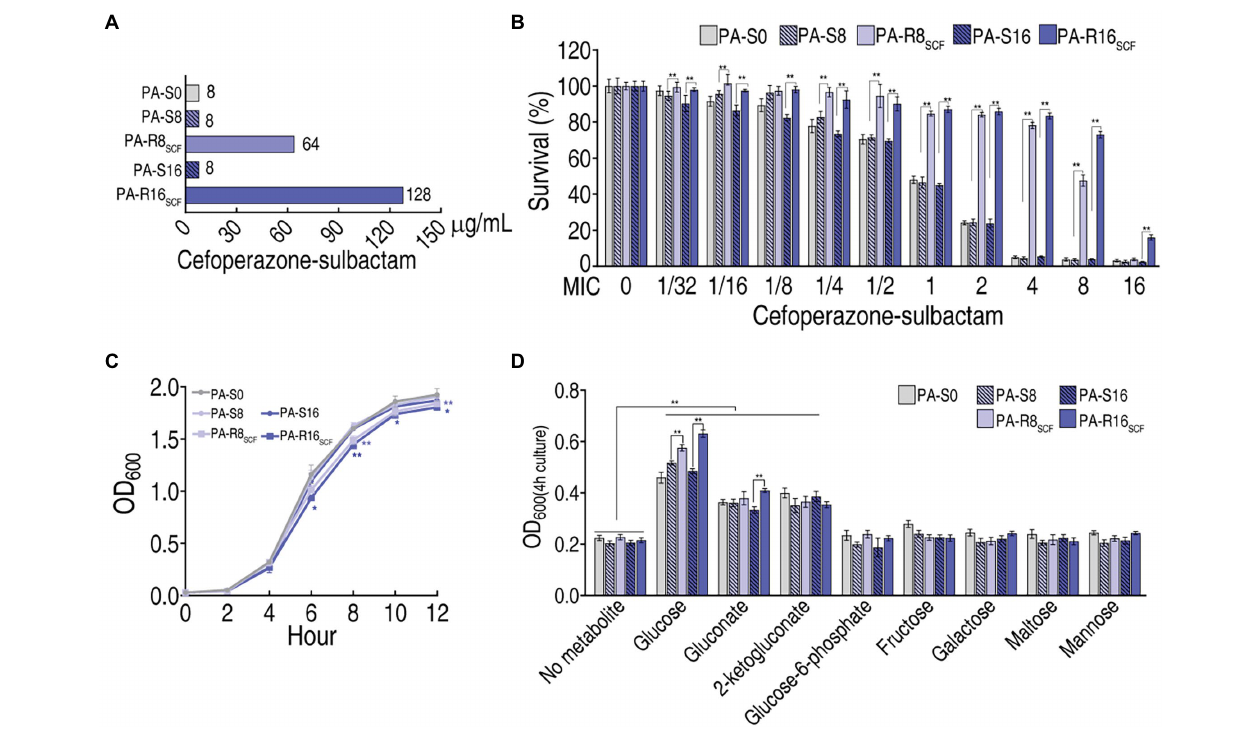
FIGURE 1 | Resistance to cefoperazone/sulbactam (SCF) and effect of sugar on growth in PA-R SCF . (A) Minimum inhibitory concentration (MIC) of three PA -S and two PA -R strains. (B) Survival capability of three PA-S and two PA-R strains. (C) Growth curve of three PA-S and two PA-R strains. (D) Effect of the indicated sugars on growth of three PA-S and two PA-R strains. Results are displayed as mean ± SEM and three biological repeats are performed. Significant differences are identified * p < 0.05, ** p <